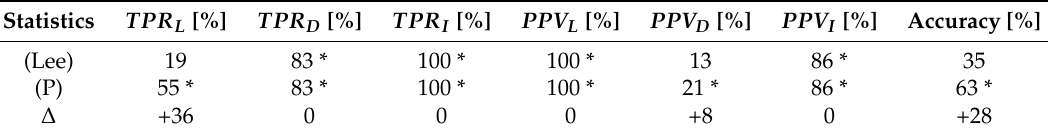
Table 7. Results of three-level classification on step sequences, with respect to the statistical parameters ( TPR L , TPR D and TPR I : true positive rate for “legal”, “doubt”, and “illegal” step sequences; PPV L , PPV D and PPV I : predict positive value for “legal”, “doubt”, and “illegal” step sequences) for Lee’s (Lee) and proposed (P) approaches. The best values for each row are highlighted with the symbol *. The ∆ value represents the difference of each statistical parameter between the two approaches